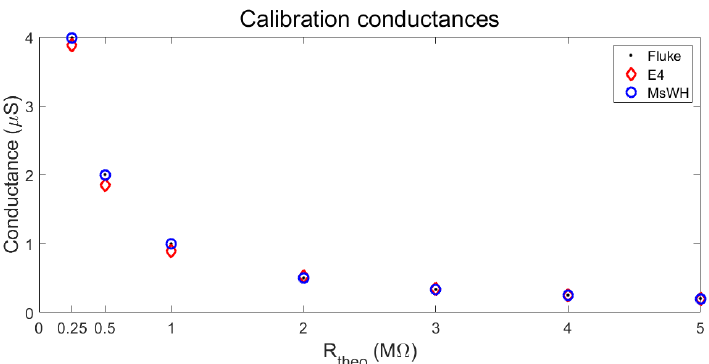
Figure 18. Conductance calibration. Experimental results. MsWH and E4.